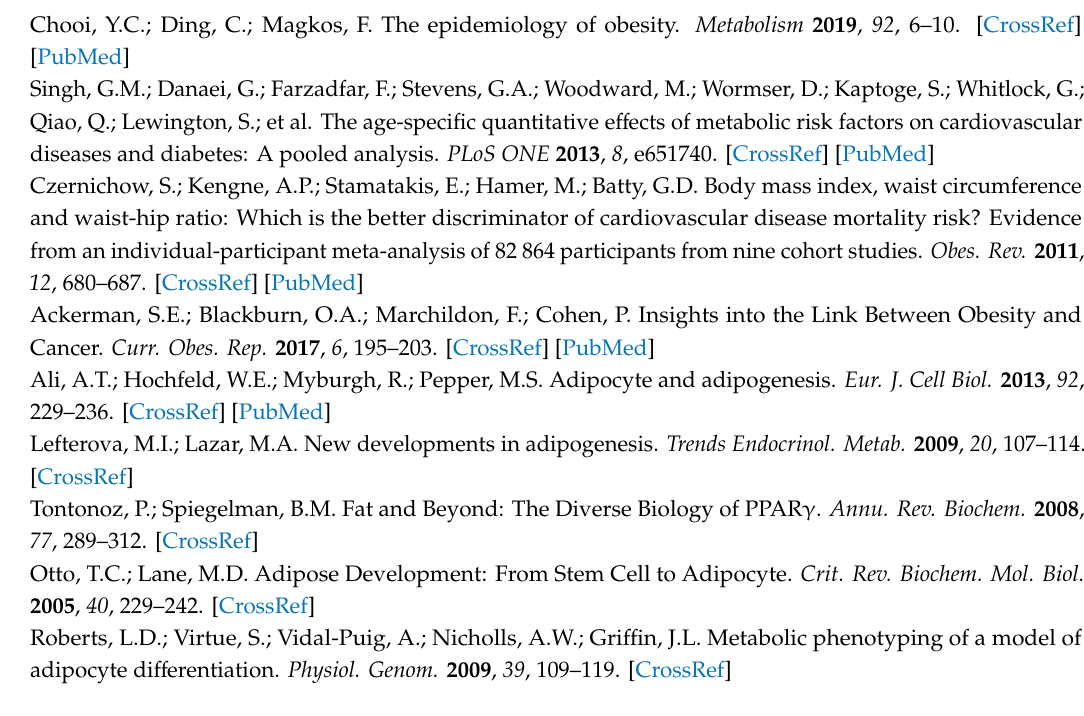
Figure S1: Analytical evaluation of the Lipidyzer ™ method for undi ff erentiated and di ff erentiated cells revealed strong linearity for most of the analyzed lipid classes; Figure S2: Representative microscopic images of SGBS cells showed successful di ff erentiation based on morphological changes and a strong increase in number and size of lipid droplets; Figure S3: Transcripts of the main adipogenic transcription factors PPAR γ ( PPARG ) and C / EBP α ( CEBPA ) were highly upregulated during adipogenesis; Figure S4: Principal component analysis (PCA) score plot showing very clear clustering of lipid species regarding the di ff erent time points of adipogenesis; Figure S5: Fatty acid concentrations and compositions changed markedly during adipogenesis in all 11 lipid classes; Figure S6: Clusters from the spearman’s rank correlation analysis consisted of distinct lipid class compositions; Figure S7: Polyunsaturated and very long-chain fatty acids were highly concentrated in FBS-containing medium used for cultivation before di ff erentiation start; Table S1: Linearity testing of method; Table S2: Repeatability and background signal testing; Table S3: Top 30 variable importance in projection (VIP) of PLS-DA for component 1 and 2, respectively; Table S4: Significances of Kruskal Wallis test; Table S5: Spearman’s rank correlation coe ffi